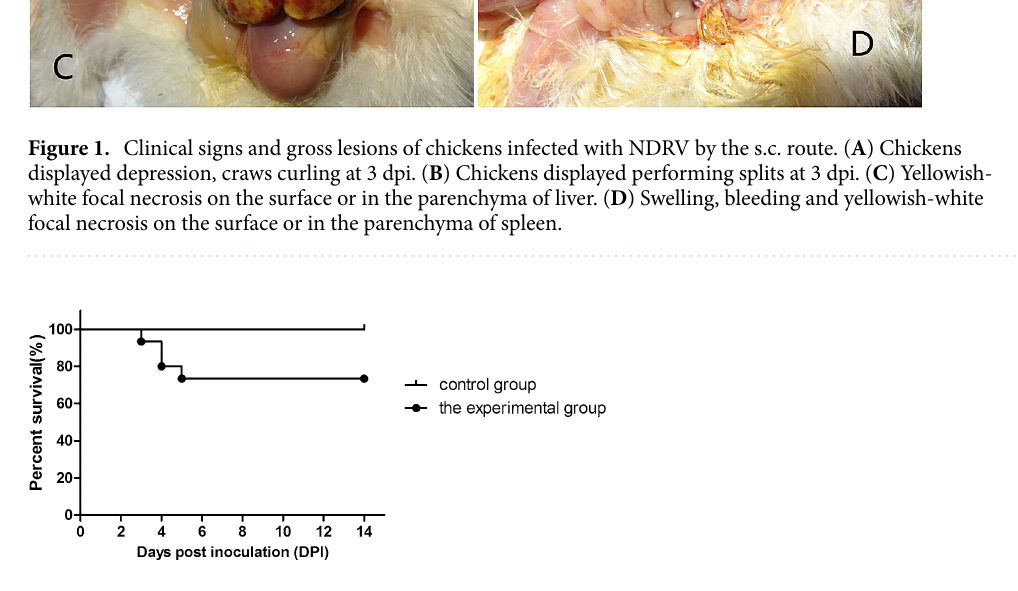
Figure 2. Survival rate of chickens infected with NDRV by the s.c. route. Five chickens died during 3 to 5 days after